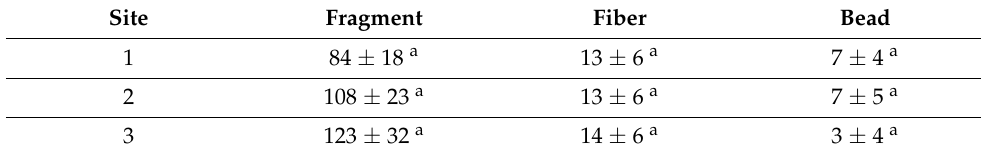
Table 3. The number of microplastic types and total MPs per gram of tissue for each site. Site Fragment Fiber Bead 1 84 ± 18 a 13 ± 6 a 7 ± 4 a 2 108 ± 23 a 13 ± 6 a 7 ± 5 a 123 ± 32 a 14 ± 6